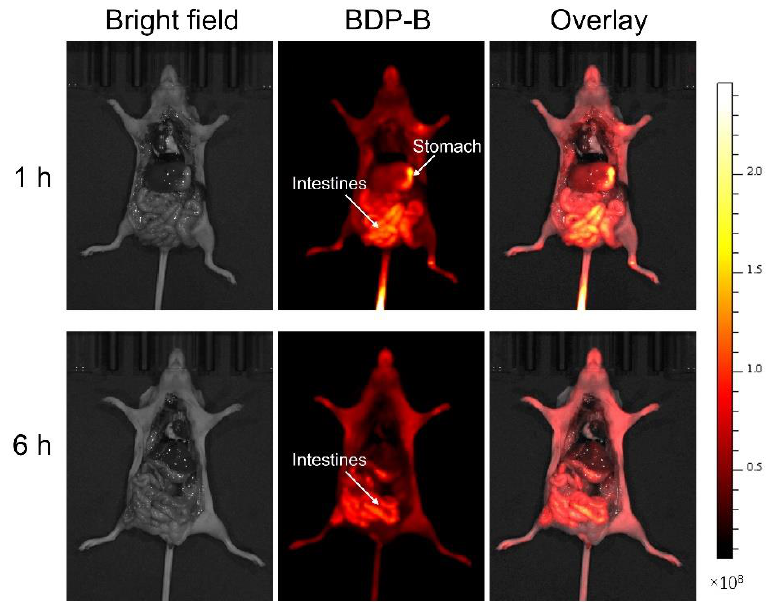
Figure 5. In vivo organ imaging at 1 and 6 h after caudal intravenous injection of BDP-B NPs .